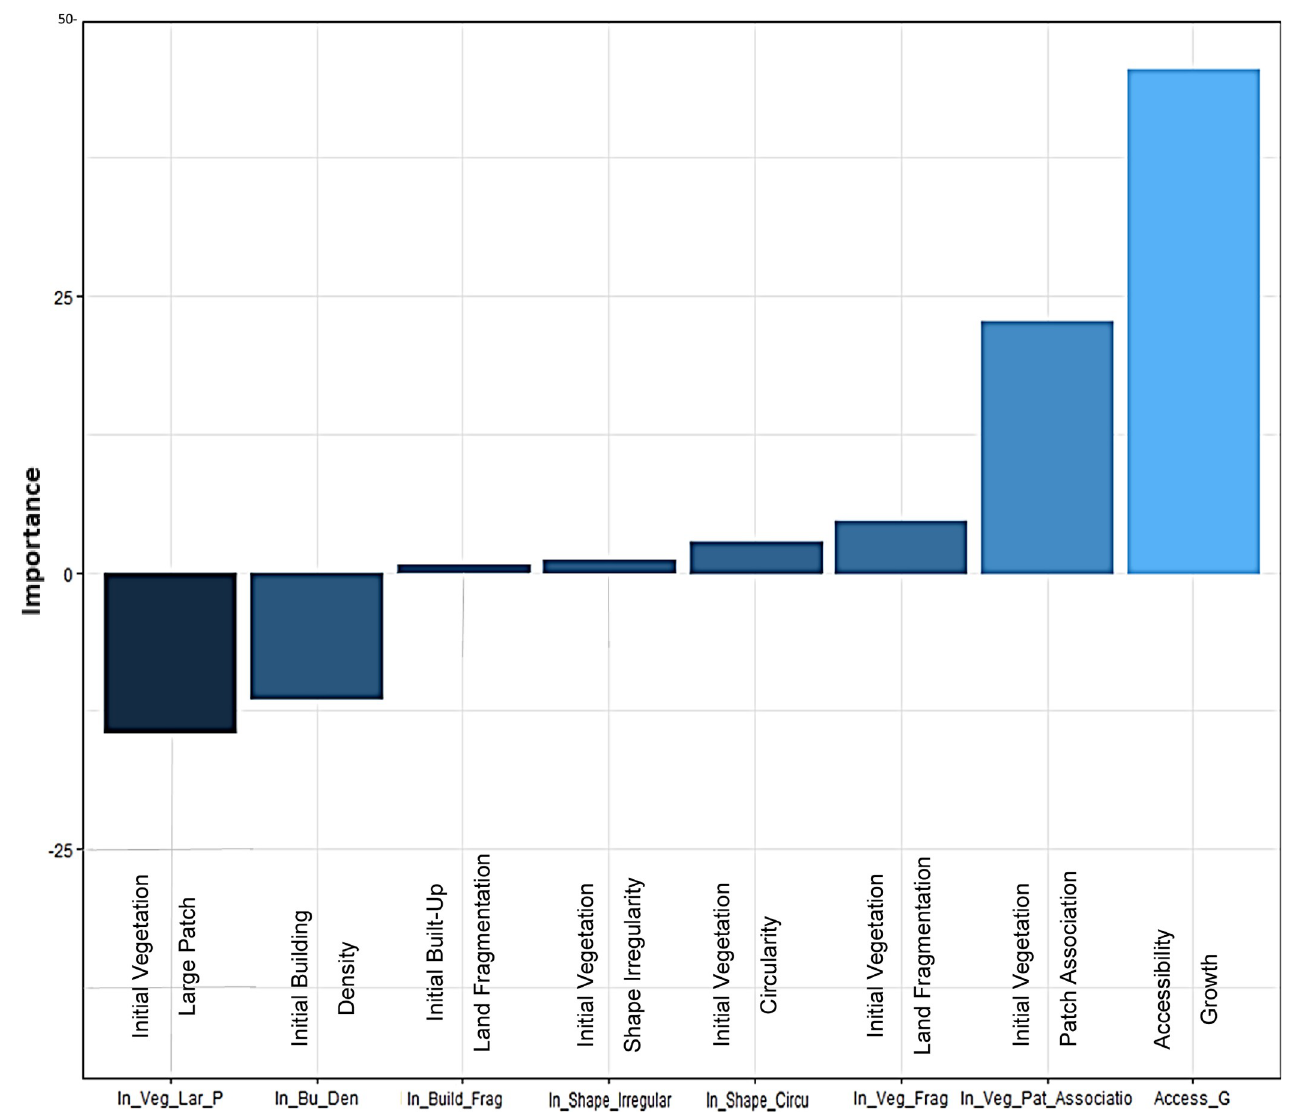
Fig 10. Results of the olden algorithm: Importance level of